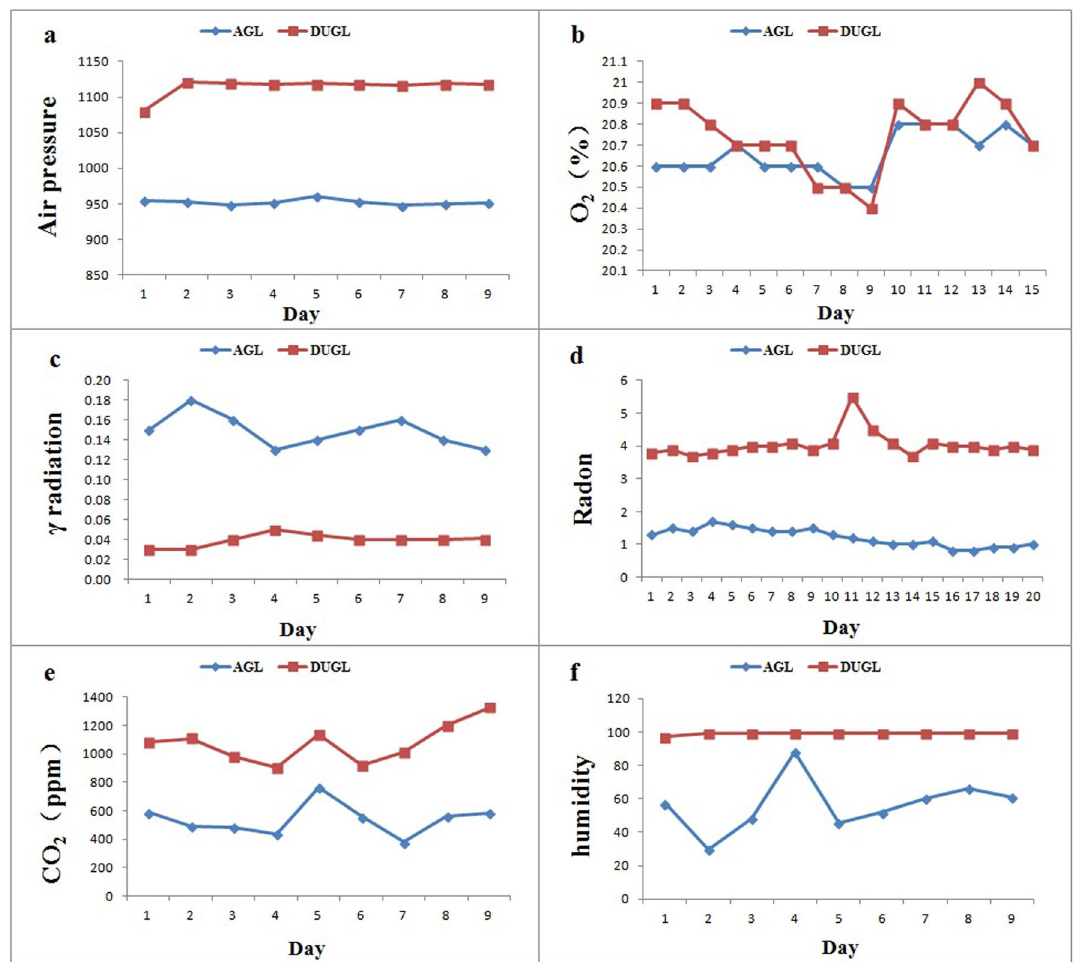
Figure 2. Variations in the environmental characteristics in the DUGL and AGL. AGL above-ground laboratory, DUGL deep underground